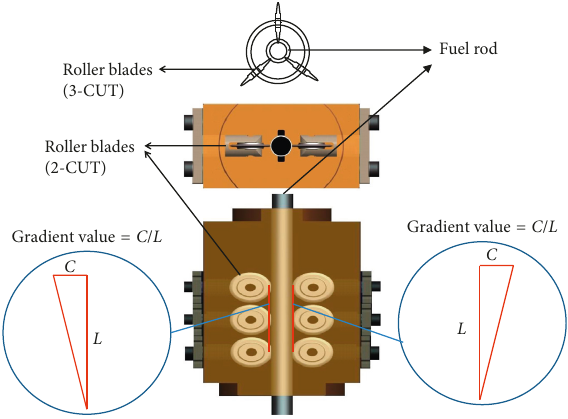
Figure 5: Roller gradient of 2-CUT and 3-CUT blade